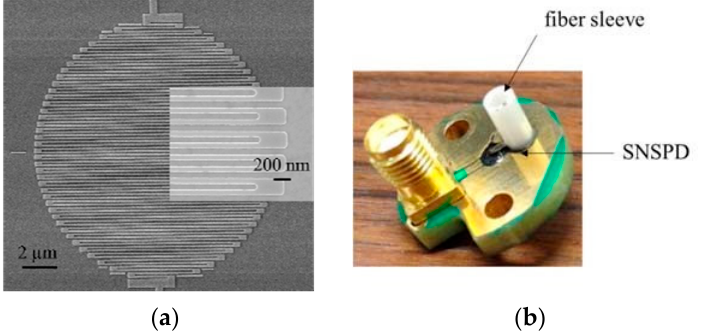
Figure 1. ( a ) Top-view scanning electron micrographs of the NbN superconducting nanowire used as active core in SNSPDs; ( b ) SNSPD device mounted on a print circuit board with fibered optical